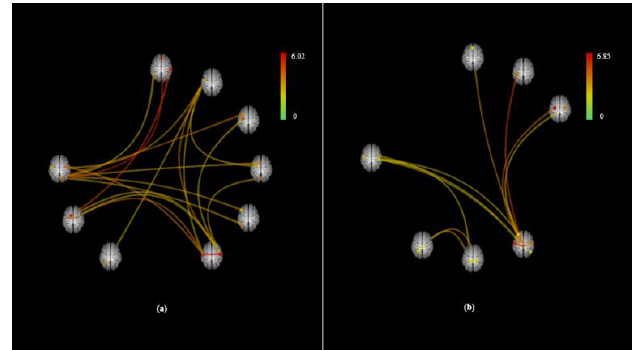
Figure 1. Region of interest (ROI)-to-ROI connectome ring maps of all selected ROI seeds in ( a ) Mouth > Nose and ( b ) Mouth < Nose contrasts. The color links are obtained at a ROI-to-ROI connections height threshold (FDR) of P < 0.05, seed ROI height threshold (uncorrected) of P < 0.05, with one-sided positive seed level correction and permutation tests. The color bar indicates the statistical T value. Abbreviations: ROI, region of interest; FDR, false discovery rate.